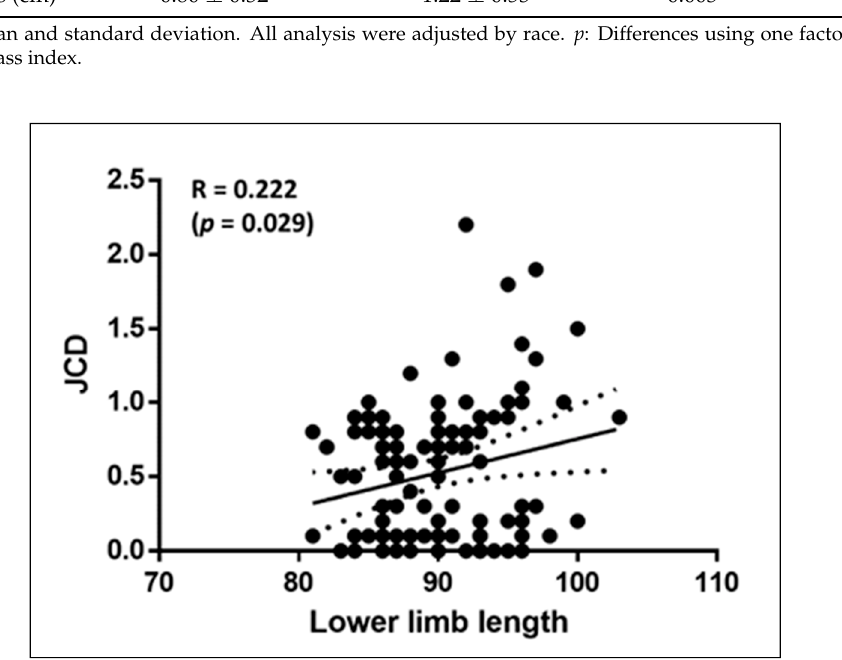
Figure 3. Pearson’s correlation (±95% confidence intervals) between joint clearance discrepancy (JCD) and lower limb length.